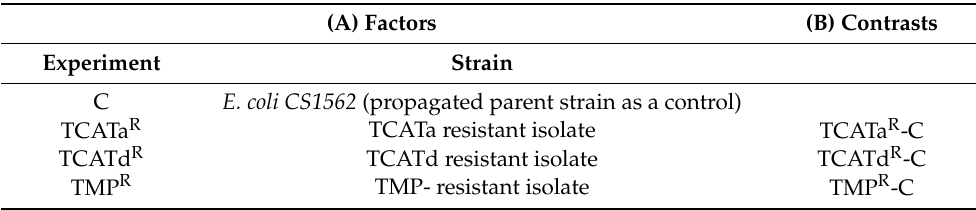
Table 4. ( A ) File describing the experiment factors. ( B ) File describing the comparisons made during the analysis of differential gene expression. Resistant isolates from each condition are characterized by a superscript R ( R ).